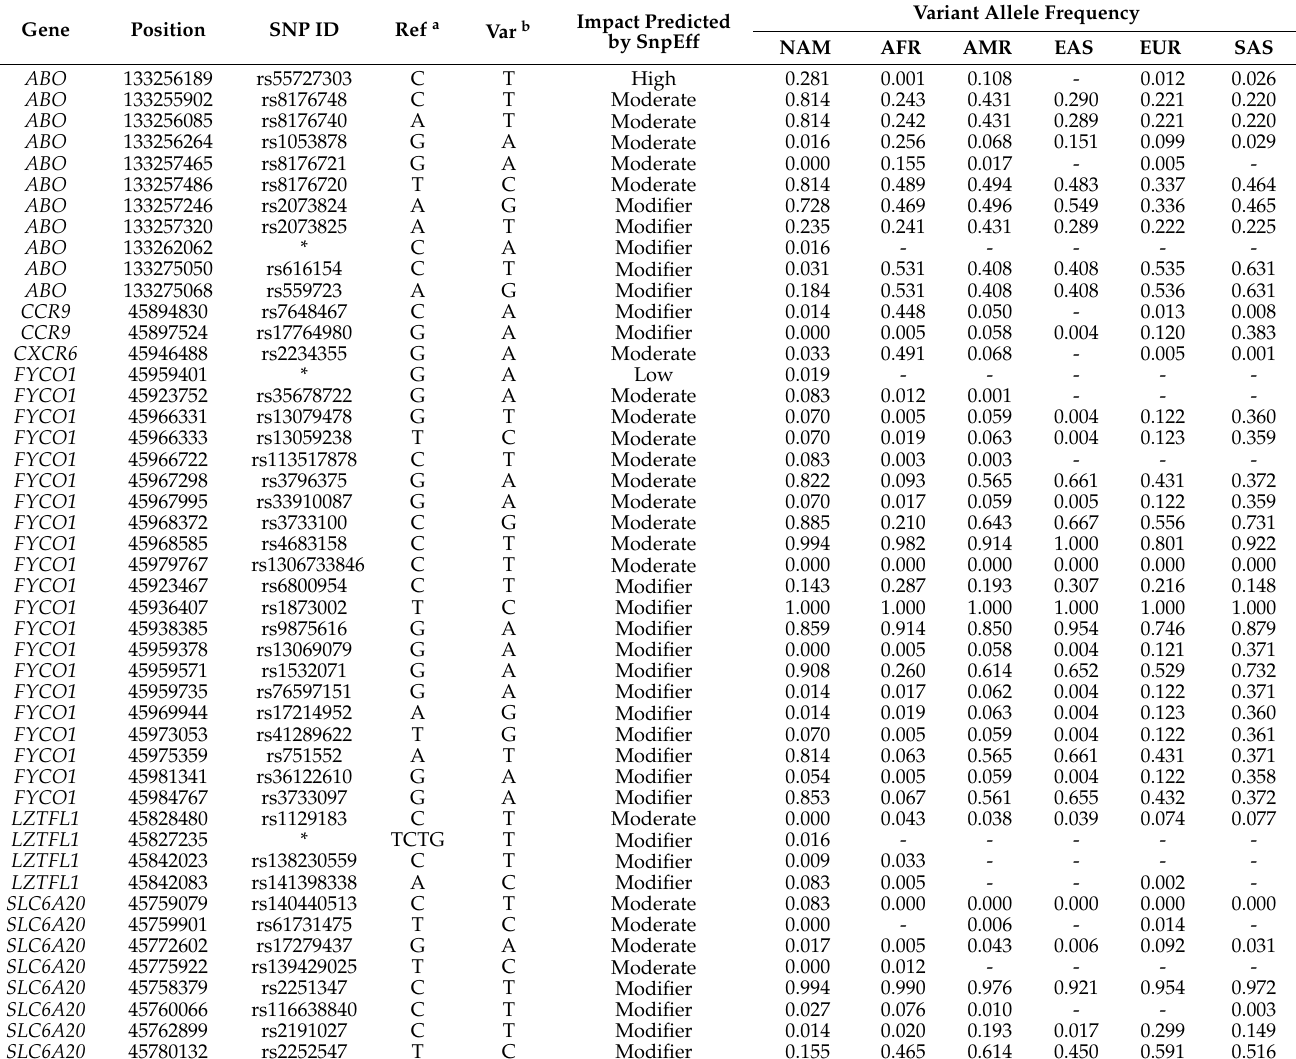
Table 2. Description of the variants with predicted high, moderate, or modifier impact, and new variants for the genes ABO , CCR9 , CXCR6 , FYCO1 , LZTFL1 , and SLC6A20